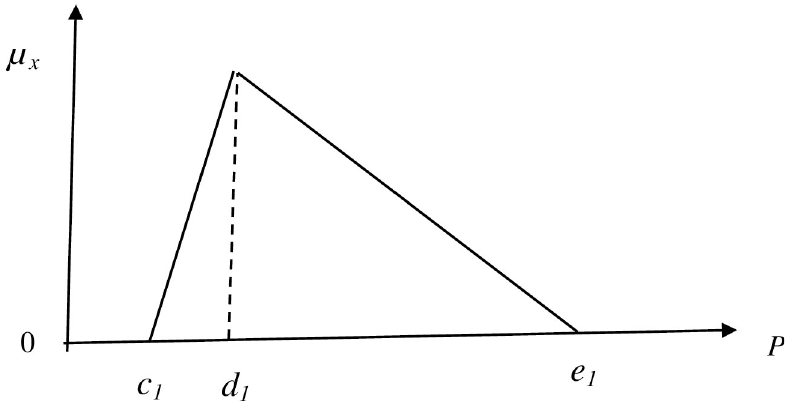
Fig 2. Triangular fuzzy number ( P